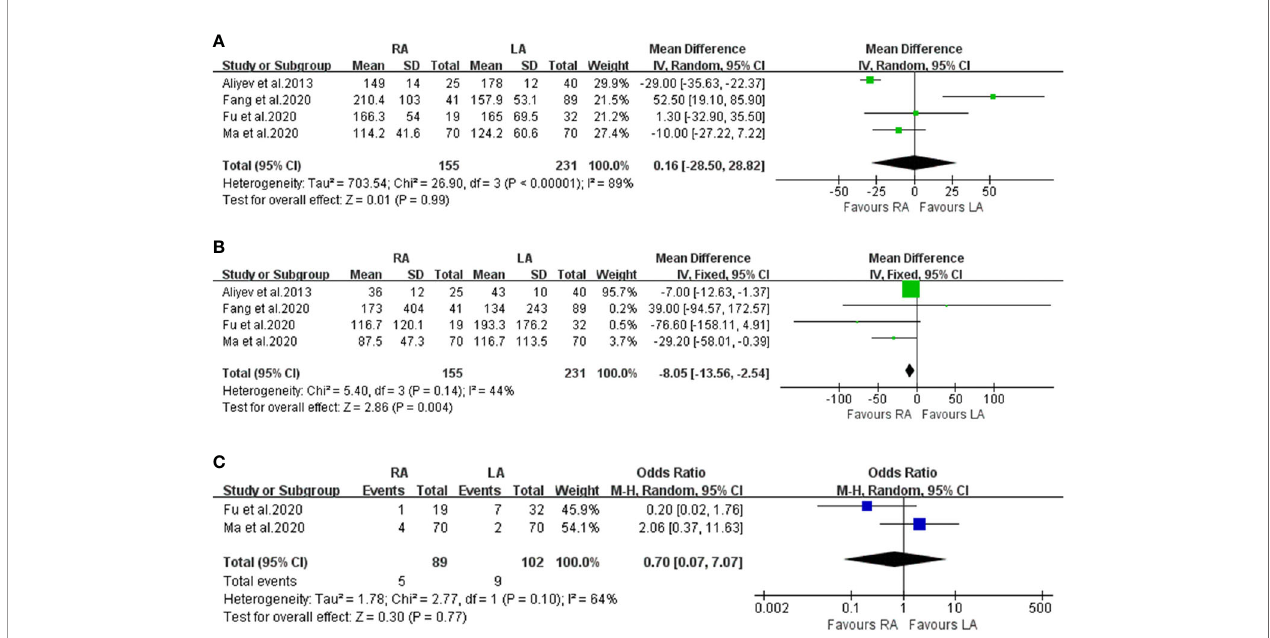
FIGURE 2 | Forest plots of perioperative outcomes: (A) operating time, (B) estimated blood loss (C) transfusion